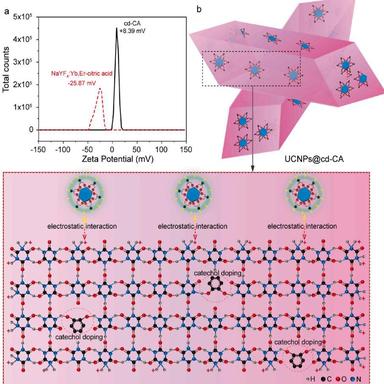
The formation mechanism of UCNPs@cd-CA. a) Zeta potentials of citric acid modified NaYF4: Yb, Er nanocrystals and cd-CA organic crystals, respectively, and b) electrostatic self-assembly of UCNPs and cd-CA into a hybrid material.